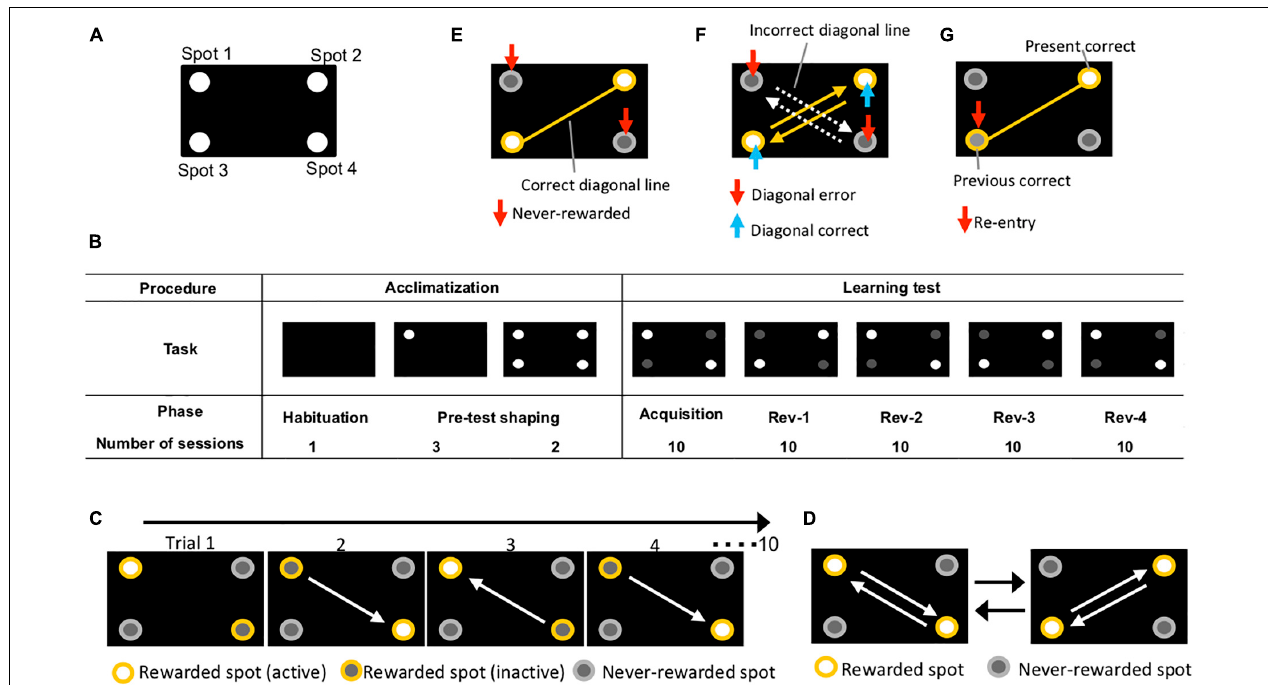
FIGURE 1 | Overview of experiment using touch screen operant system. (A) Position of spots. Four holes were cut in an acryl plate and the plate was placed on a touch screen. (B) Experimental procedure. Acclimatization comprised “habituation” and “pre-test shaping” (1 and 5 days, respectively). The learning test included “acquisition” and “reversal” stages 1, 2, 3, and 4 (10 sessions/phase). (C) Diagrams of behavioral sequencing task. Mice obtained a reward by alternately touching the two distantly positioned reward spots (yellow open circles). (D) Serial reversal learning of the behavioral sequencing task. The pattern of corner conditions (rewarded or never-rewarded) was reversely switched for each phase. The white arrows indicate the expected shuttling path on which mice shuttle between positioned rewarded spots. (E) Never-rewarded. A nose-poking of the gray circles, which is not on the correct diagonal line, was counted as “never-rewarded” choice (red arrows). Results of first-choice never-rewarded rates and never-rewarded rates of the first 100 trials are shown in Figures 3 , 4B , respectively. (F) Diagonal correct; diagonal error. Shuttle nose-poking (blue arrows) of rewarded spots (yellow spots) on the correct diagonal line (yellow lines) was counted as “diagonal correct” choice. Shuttle nose-poking (red arrows) of never-rewarded spots (gray spots) on the incorrect diagonal line (white dot arrows) was counted as “diagonal error” choice. Data of cumulative diagonal correct and error are shown in Figure 4A . (G) Re-entry. Nose-poking of the incorrect spot (red arrows) on correct diagonal line (yellow line), the last correct spot, was counted as “re-entry.” Results of re-entry rate are shown in Figures 2 , 3D .